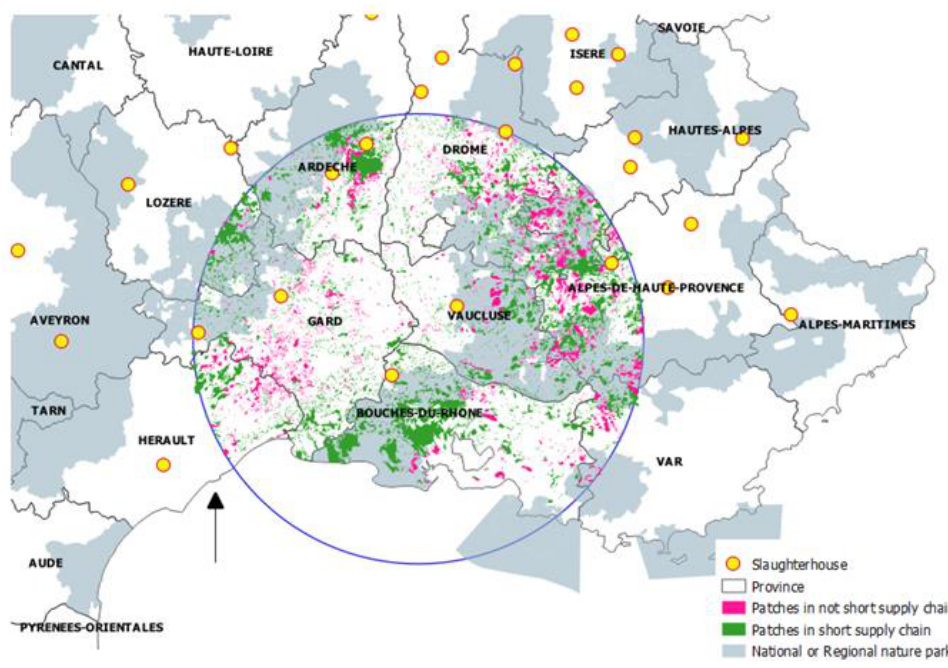
Figure 2. Map on left shows unconnected patches, while map on the right groups patches together using the dilation/erosion method.